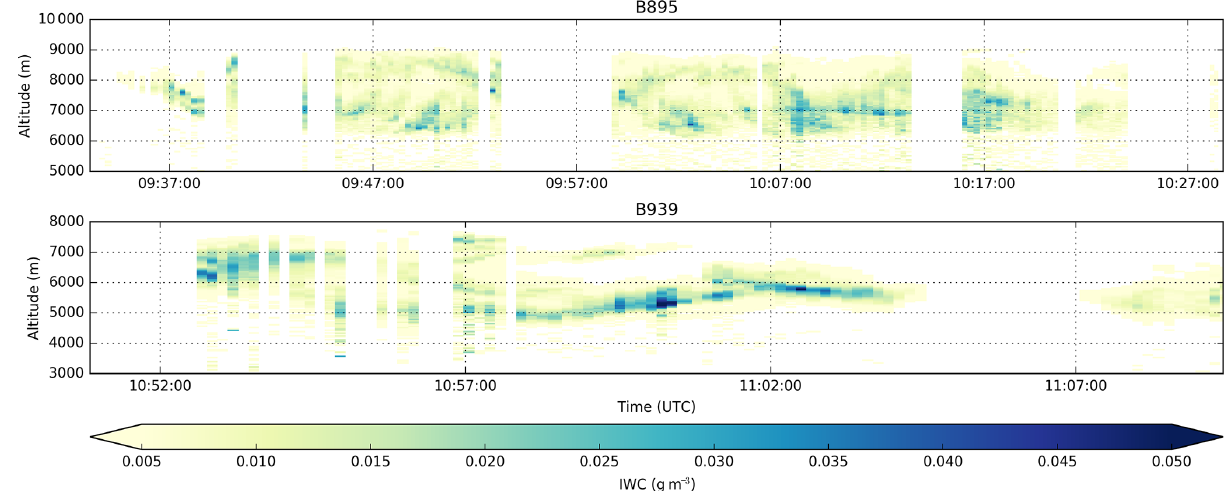
Figure 7. Lidar-derived ice water content profiles. Missing data correspond to aircraft turns or times when the lidar did not penetrate the full cloud